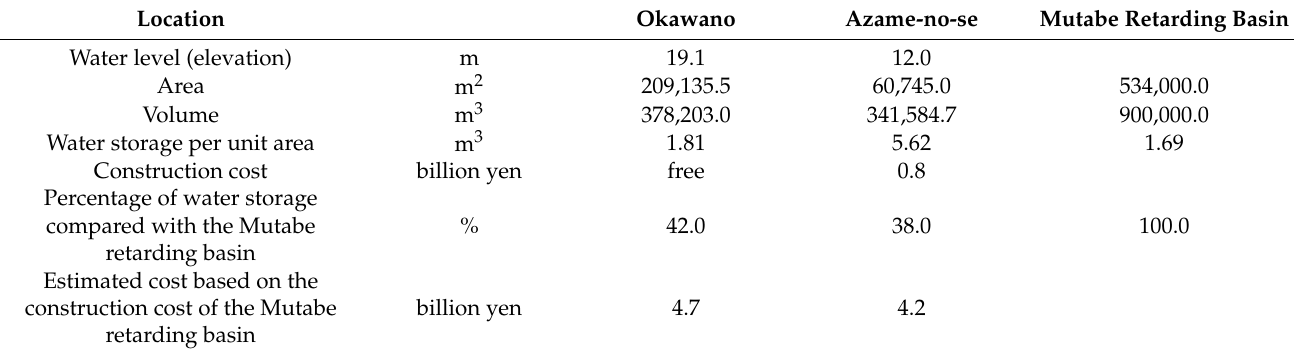
Table 7. Comparison of effectiveness and costs